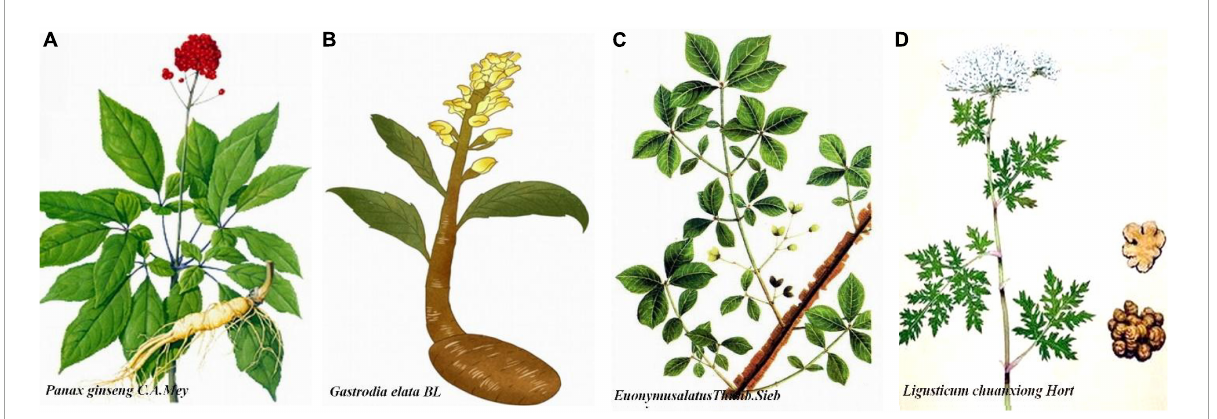
FIGURE1 Detailing of herbal Shen Ma Yi Zhi granule (SMYZG) components. (A) Panax Ginseng C.A. Mey ; (B) Gastrodia elata Bl ; (C) Euonymus alatus (Thunb.) Sieb ; (D) Ligusticum chuanxiong Hort . Sources for the images within this figure: 699pic.com and Chinese Pharmacopoeia.